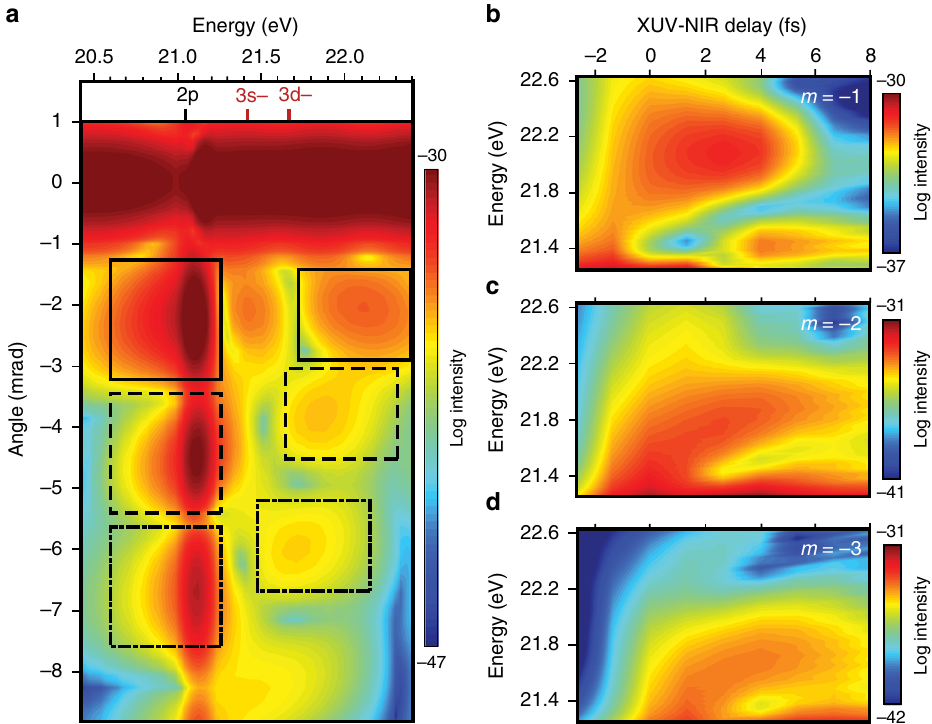
Fig. 3 Far and near- fi eld results of the time-dependent Schrödinger and Maxwell ’ s equations. a Calculated log spectral intensity for the 1s2p resonance and 3d − light-induced state (LIS) of helium gas propagated to the far fi eld. The selected regions indicate distinct orders of either 2p or 3d − features. The delay dependence of the LIS emission features associated with the b m = − 1, c m = − 2, and d m = − 3 grating orders are obtained by integrating vertically over the three highest energy black boxes in a in the near fi eld. The data in b – d have been smoothed to re fl ect the lack of carrier envelope phase control in the